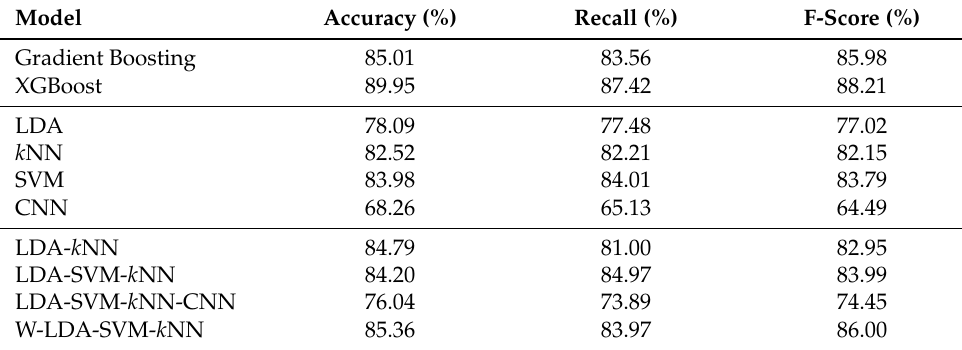
Table 3. Test results using 8-channel data of ALS